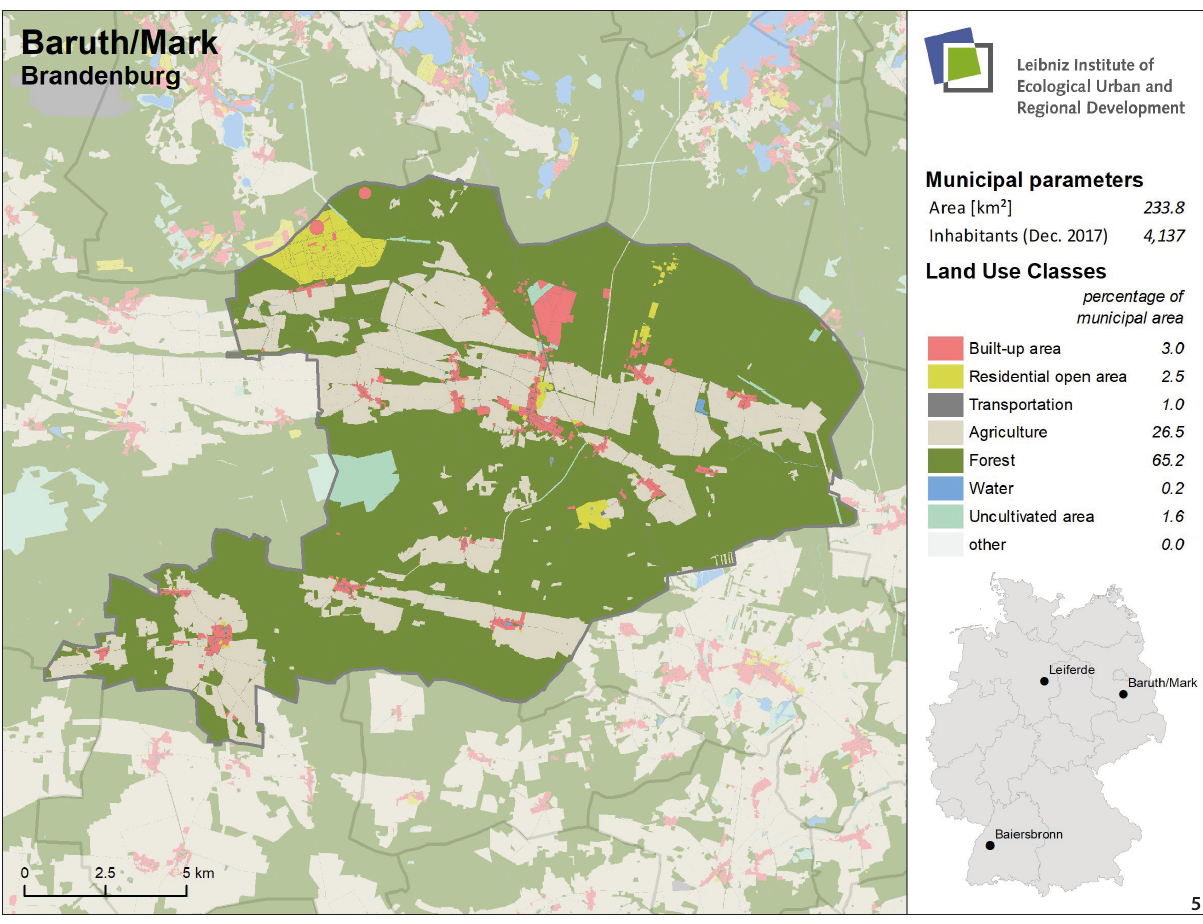
Figure 5 Land use in the rural municipality of Baruth/Mark (Source: IOER Monitor 2019, Geobasis-DE/BKG